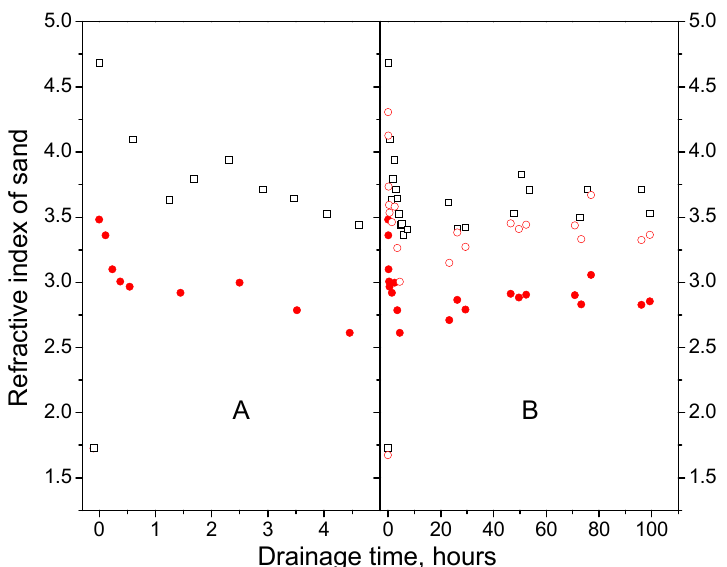
Figure 6. Dependence of the sand refractive index on the water drainage time on narrow ( A ) and wide ( B ) time intervals. Calculation by Equation (5): red circles ● —experiment 2; black empty squares □ —experiment 3; red empty circles ○ —calculation by Equation (19) in experiment 3.